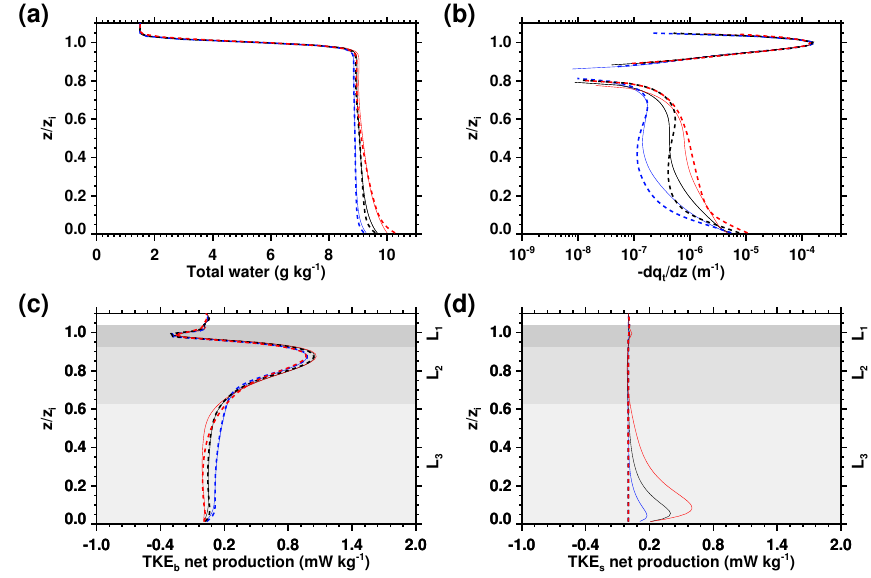
Figure 16. Buoyancy- and shear-driven dynamics. Profiles averaged over 1h in the afternoon (22:30–23:30UT) from simulations L − (blue), L 0 (black), L + (red), solid curves, and from simulations L − production, TKE s shear production of turbulence kinetic